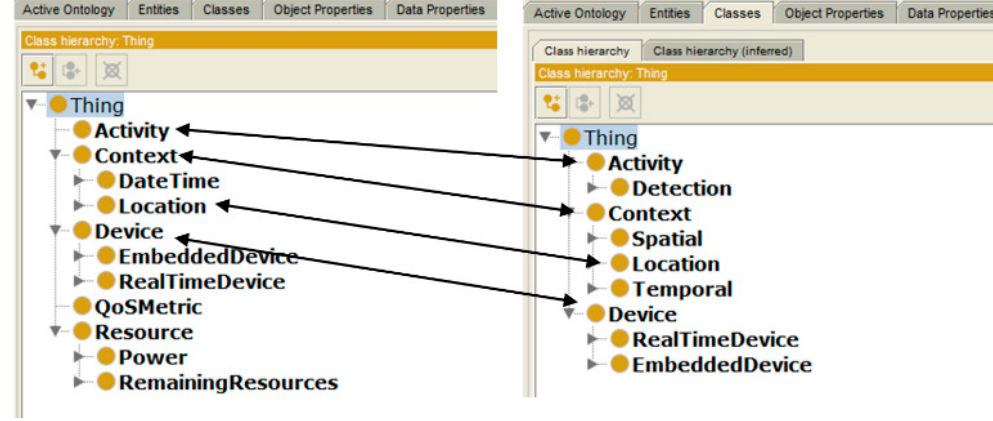
Figure 3. Unified Modeling Language (UML) Meta-model for autonomous mobile robot ontology. To share information on the web without disputes, Description Logic (DL, formal knowledge representation language) can be used. DL is based on first-order logic to represent the knowledge of a particular domain and then the use of domain concepts (knowledge) to specify relationships among objects and individuals occurring in that domain. Moreover, since the knowledge-representing systems answer the queries of a user in a reasonable time, DL can be used to describe the information of services as: SrvDemand → srv:Service ∧ ( ∃ srv:has_Location.srvc:MedicalWard) ∧ ( ∃ srvc: performs_Activity.srvc:CarbonDioxideMeasurement) ∧ ( ∃ srvc:has_RemainingBatteryPower.srv c ≥ 80) ∧ ( ∃ srvc:has_Reliability.srvc ≥ 95) ∧ ( ∃ srvc:has_ResponseTime.srvc ≤ 1) Following is the description logic notions of a few device services.